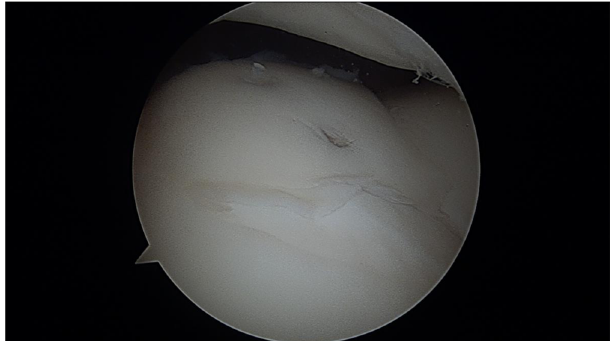
Figure 7. De fi nitive fi xation of the chondral fragment using three bioabsorbable pins in a triangular